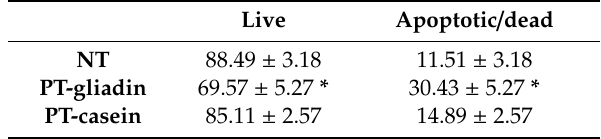
Table 3. Apoptotic analysis of HT-29 cells after treatment with digested gliadin or casein (1 µ g / µ L). The Annexin V protocol was performed using a Muse ® Cell Analyzer (Merck) at 24 h p.t. The obtained values are reported as mean ± SE. The asterisks indicate p < 0.05, ANOVA one-way, as compared with NT sample. The experiments were performed in triplicate. Cytofluorimetric plots are reported in Supplementary Figure 10.